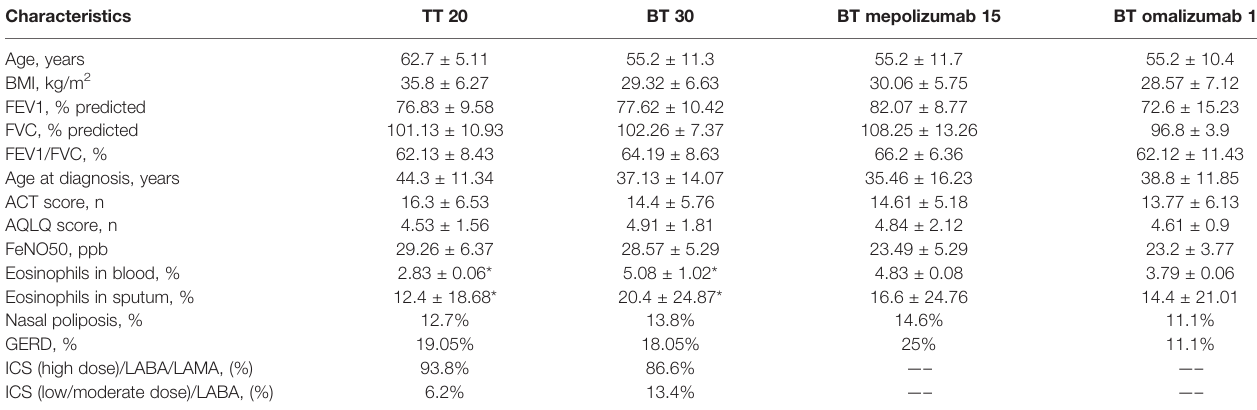
TABLE 1 | Population baseline characteristics at T0. Characteristics